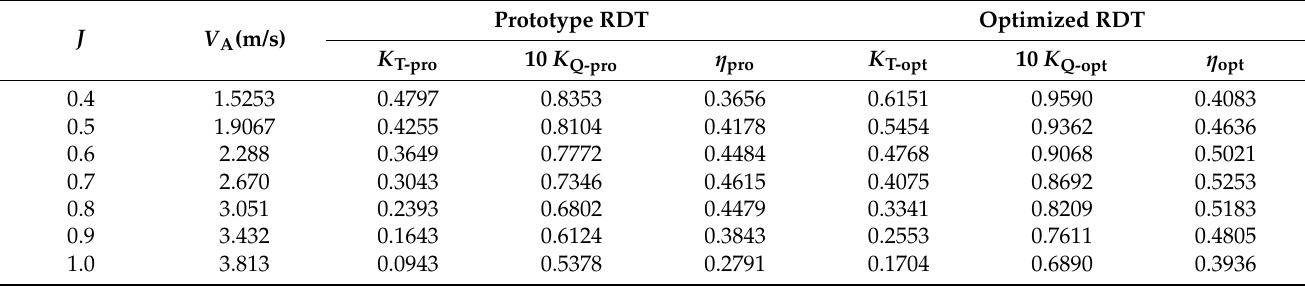
Table 9. Comparison of the simulation results between the prototype RDT and optimized RDT.